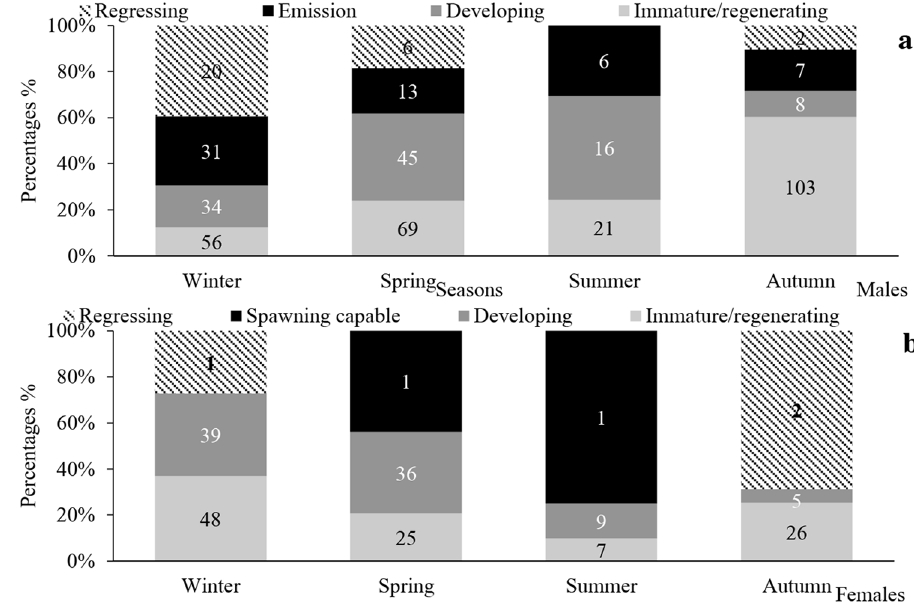
Fig. 9. Seasonal maturity stages of P. blennoides from the Algerian coast.